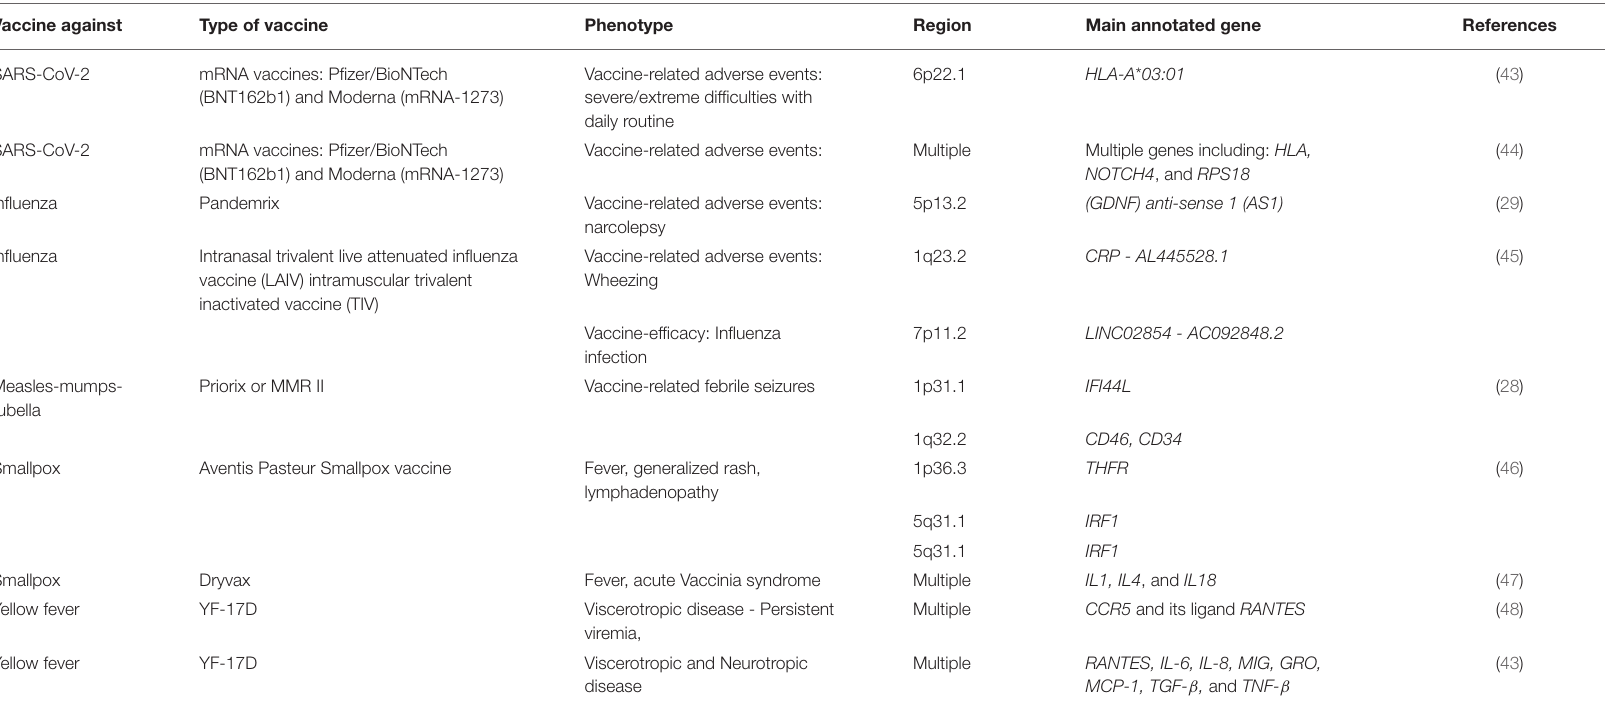
TABLE 2 | List of all genome wide associaitons on vaccine adverse events. Vaccine